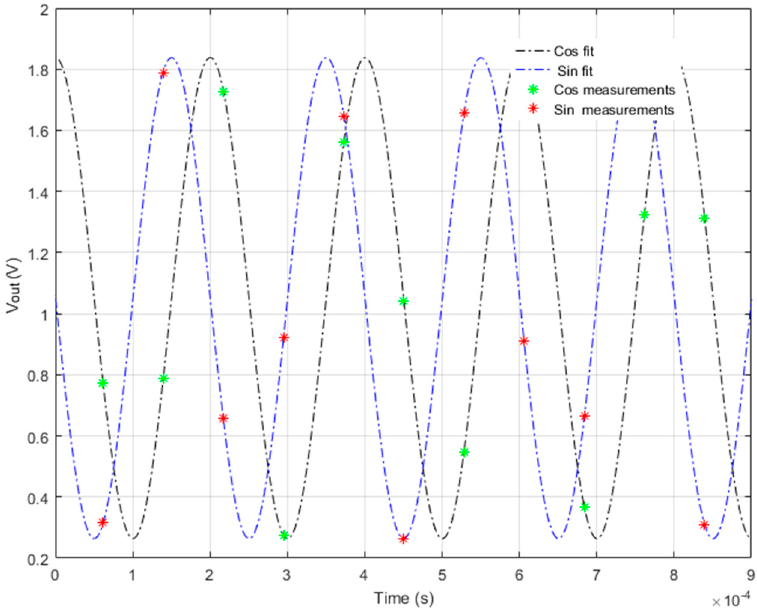
Figure 16. Signal acquisition using the proposed ADC for a sine voltage (red dots). Cosine signal is digitally recovered from the Main Memory using the sine values.